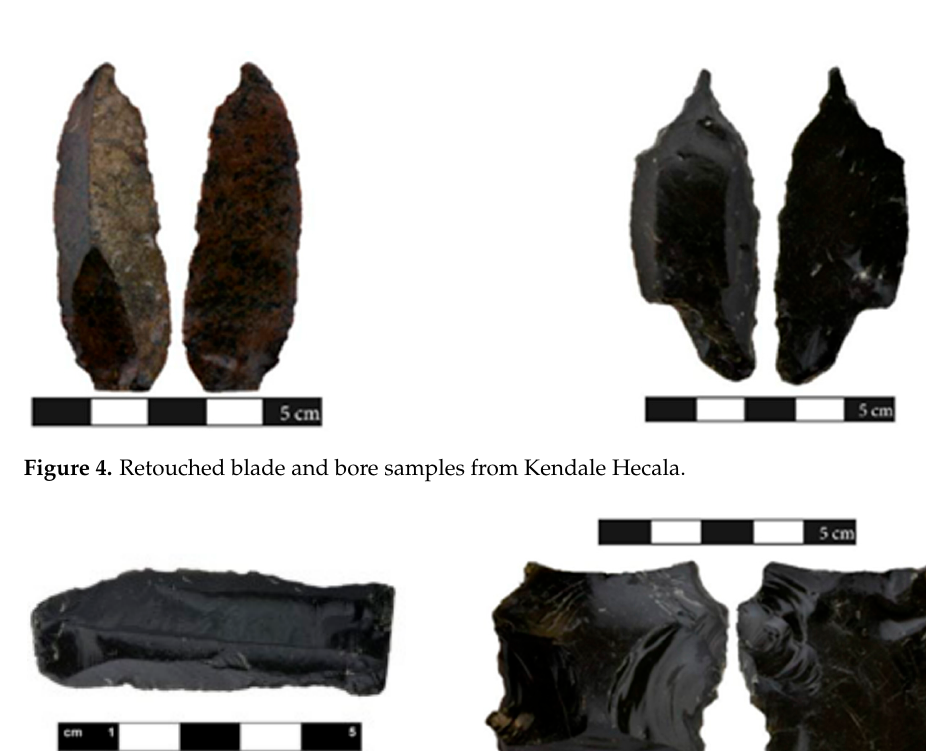
Table 2. Contextual and technological information for the analyzed Kendale Hecala II artefacts dated to cal. 5600–5000 B.C.